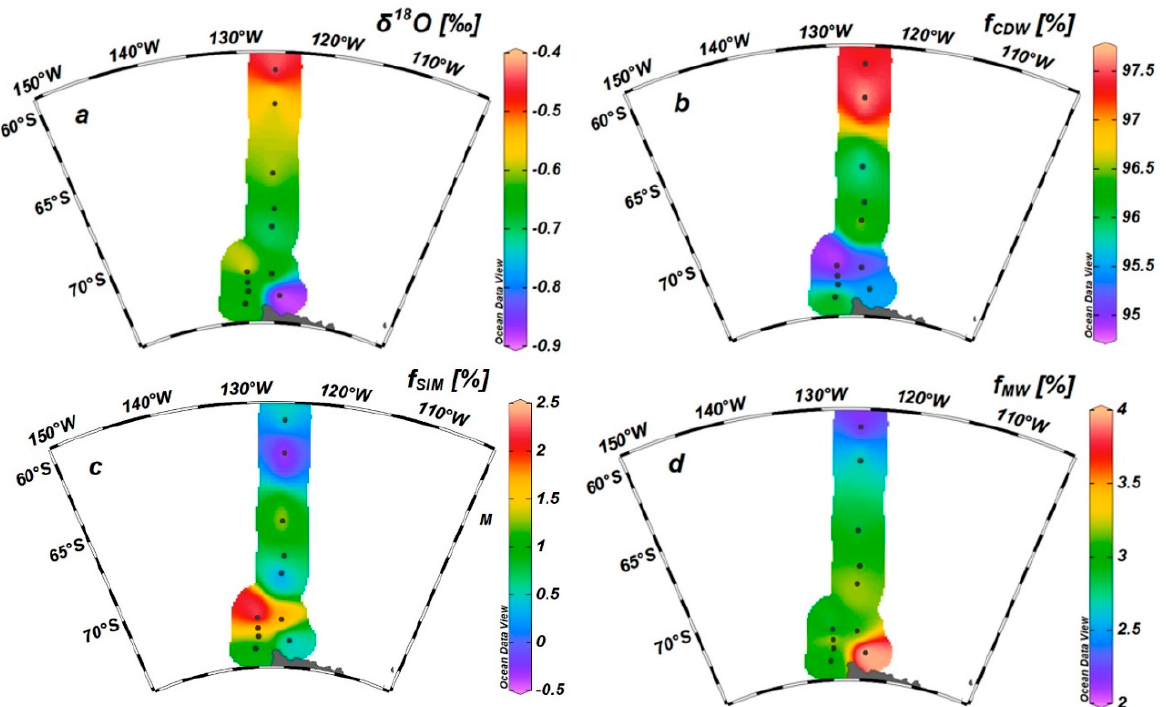
Figure 2. Spatial distribution of δ 18O (‰) ( a ) and fractions of circumpolar deep water (CDW) (%) ( b ), sea ice meltwater (%) ( c ), and meteoric water (%) ( d ) in surface water. The fractions of sea ice meltwater (f SIM ) ranged from − 0.42% (station A1-04) to 2.34% (station A2-02) with an average of 0.99% ± 0.78%. Note that the f SIM values in the surface and subsurface water samples of some stations were negative, such as at 50 m at station A2-02, 40 m at station A2-08, and 0 and 25 m at station A2-15, showing the effect of the